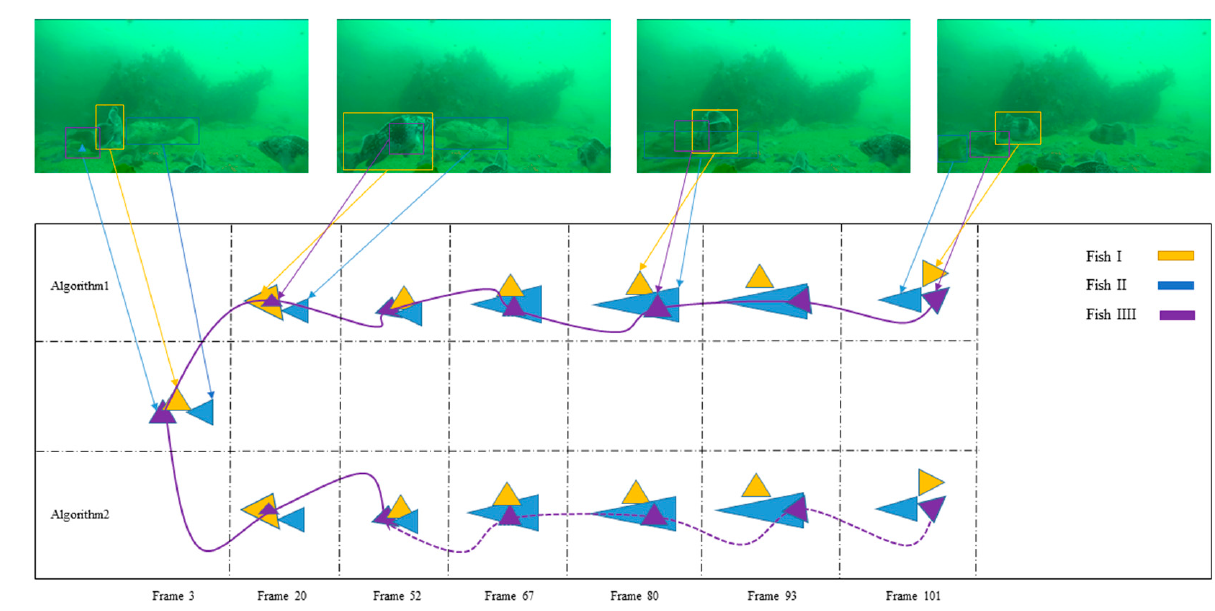
Figure 6. Visualization result of the different algorithms. We selected seven sequences from the validation set of our dataset, and show the effectiveness of FSTA in handling occlusion.